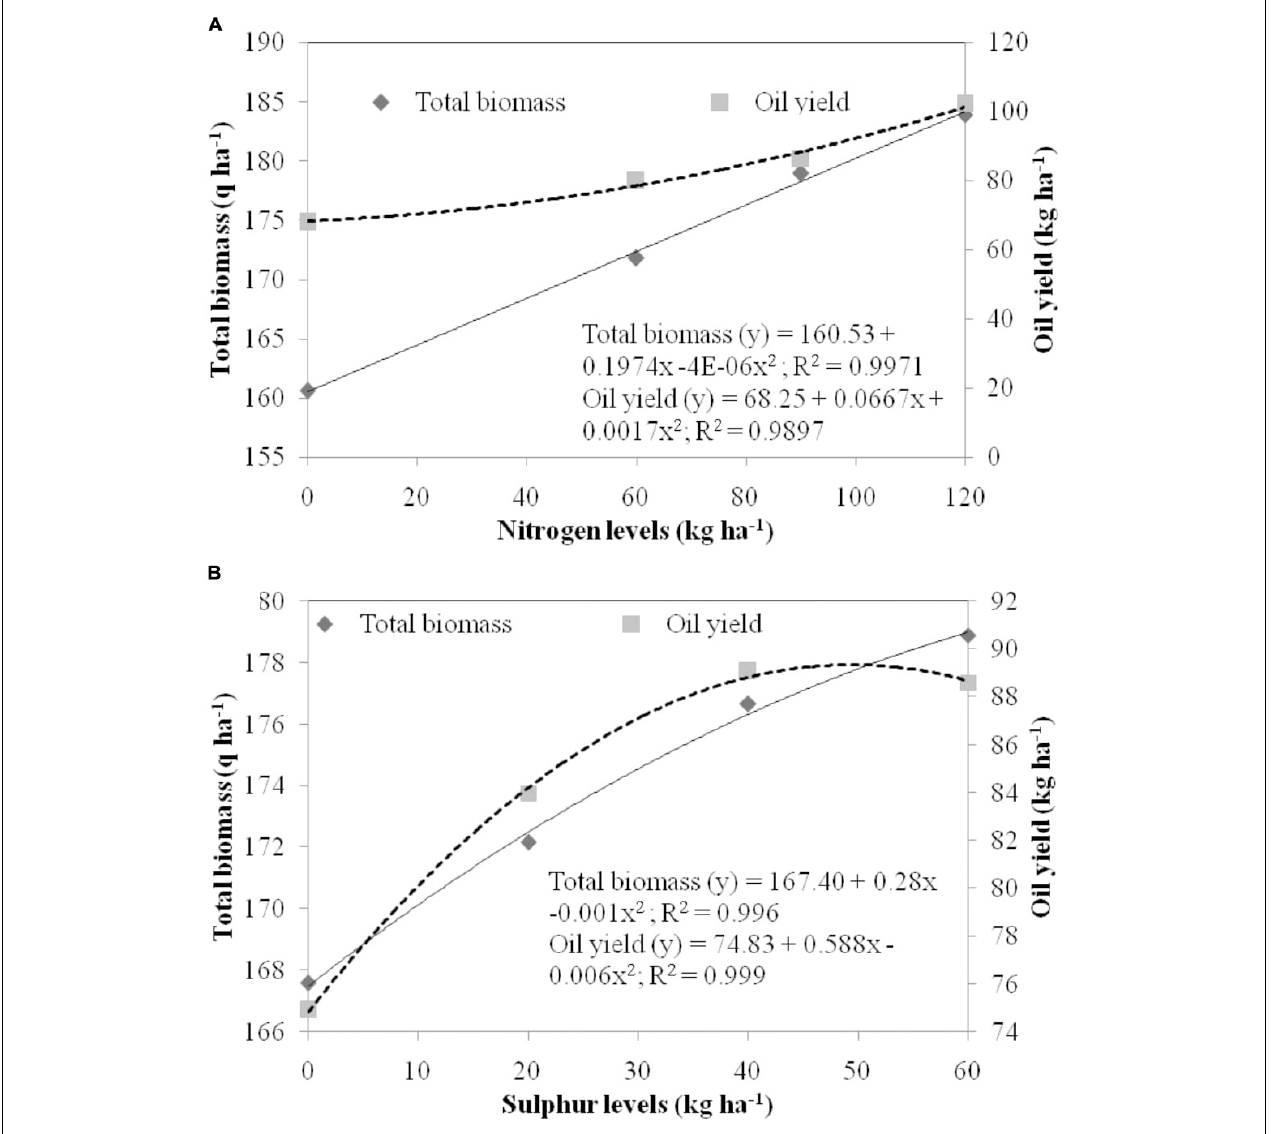
FIGURE 3 | Regression equation between independent variable, (A) levels of nitrogen (B) levels of sulfur and dependent variables, i.e., total biomass (q ha - 1 ) and oil yield (kg ha - 1 ). The doses of nitrogen and sulfur are represented in the primary X axis. Total biomass and oil yield are presented in the primary Y axis and secondary Y axis,